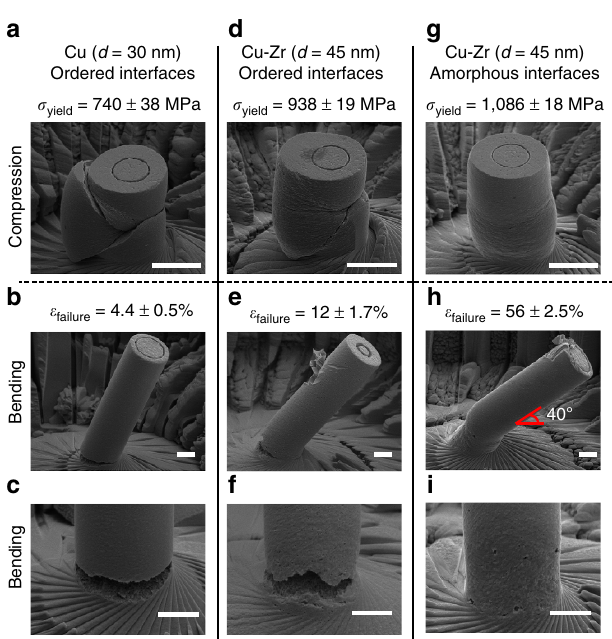
Figure 3 | Mechanical testing results from nanocrystalline Cu and Cu-Zr samples. Failed micropillars after compression, as well as yield strength measurements, are shown for ( a ) pure Cu with ordered interfaces, ( d ) Cu-Zr with ordered interfaces and ( g ) Cu-Zr with amorphous intergranular films (scale bars, 5 m m). Failed micropillars after bending, as well as strain-to-failure measurements, are shown for ( b , c ) pure Cu with ordered interfaces, ( e , f ) Cu-Zr with ordered interfaces and ( h , i ) Cu-Zr with amorphous intergranular films (scale bars, 2 m m). A nanocrystalline alloy with AIFs can be both stronger and more ductile than its traditional, pure metal